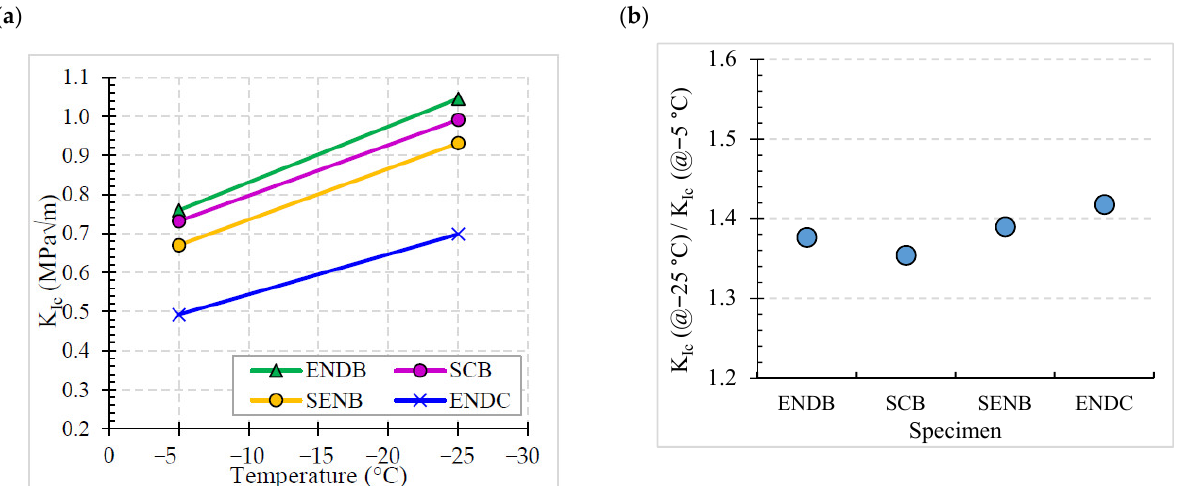
Figure 12. ( a ) Influence of test temperature on the measured K Ic values of HMA mixture for different mode I specimen types and ( b ) fracture toughness ratio (K Ic (@−25 °C) /K Ic (@−5 °C) ) for the investigated mode I samples.